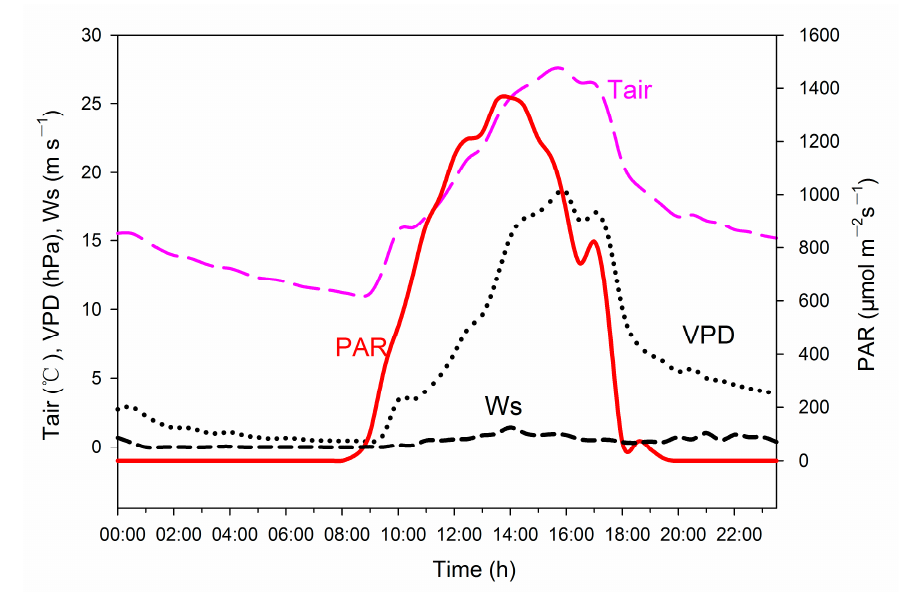
Figure 1. Air temperature (Ta), vapor pressure deficit (VPD), photosynthetic active radiation (PAR) and wind speed (Ws) during the canopy temperature measurements.